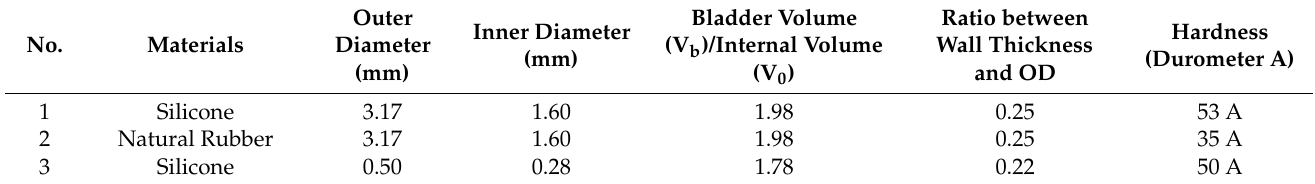
Table 2. Specifications of elastomeric bladders used in